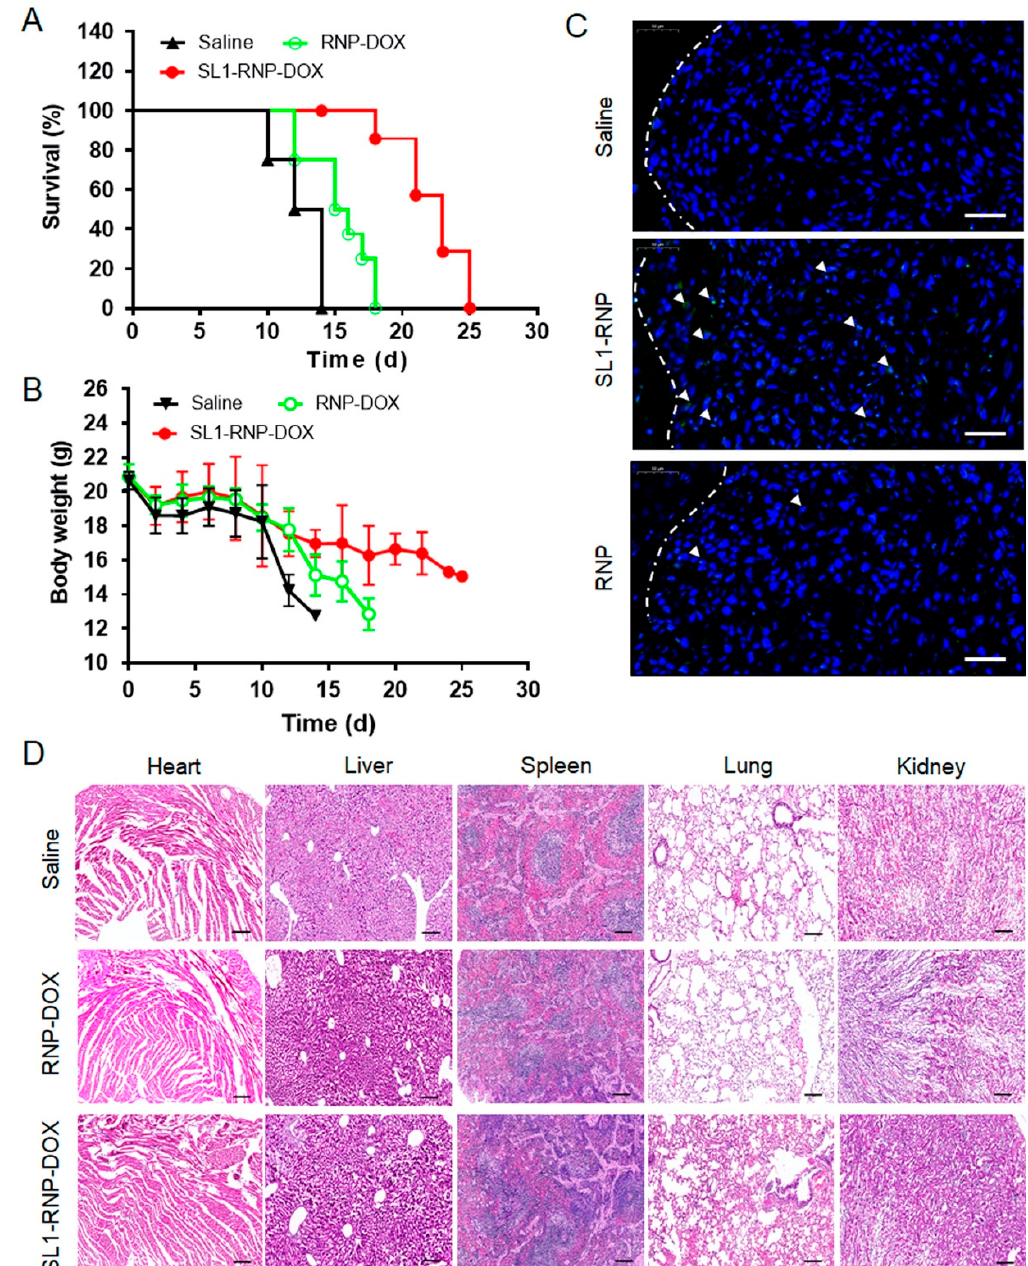
Figure 7. Anti-glioblastoma efficacy in vivo. ( A ) Survival curve of the glioblastoma − bearing nude mice received SL1 − RNP − DOX, RNP − DOX or saline via intravenous injection at 3, 6, 9 and 12 days after U87MG inoculation ( n = 8). ( B ) Animal body weight changes during treatment with different formulations ( n = 8). ( C ) TUNEL assay of U87MG tumor tissues treated with different formulations 10 days after U87MG inoculation ( n = 3). The white triangle indicated the cells apoptosis. Scale bar = 100 μ m. Green, cell apoptosis. Blue, cell nuclei. ( D ) H&E staining of slices of major organs from mouse models in different treatment groups at 24 h after intravenous injection ( n = 3). Scale bar = 400 μ m.